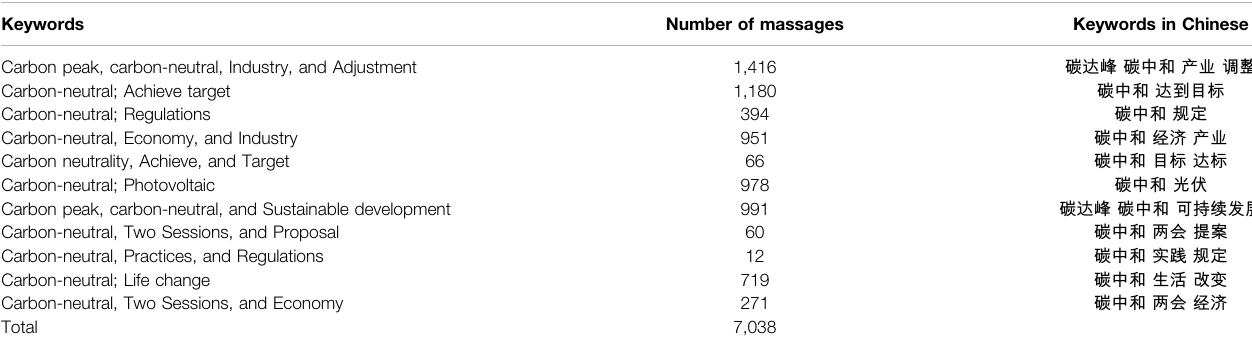
TABLE 2 | Total amount of the Weibo data.